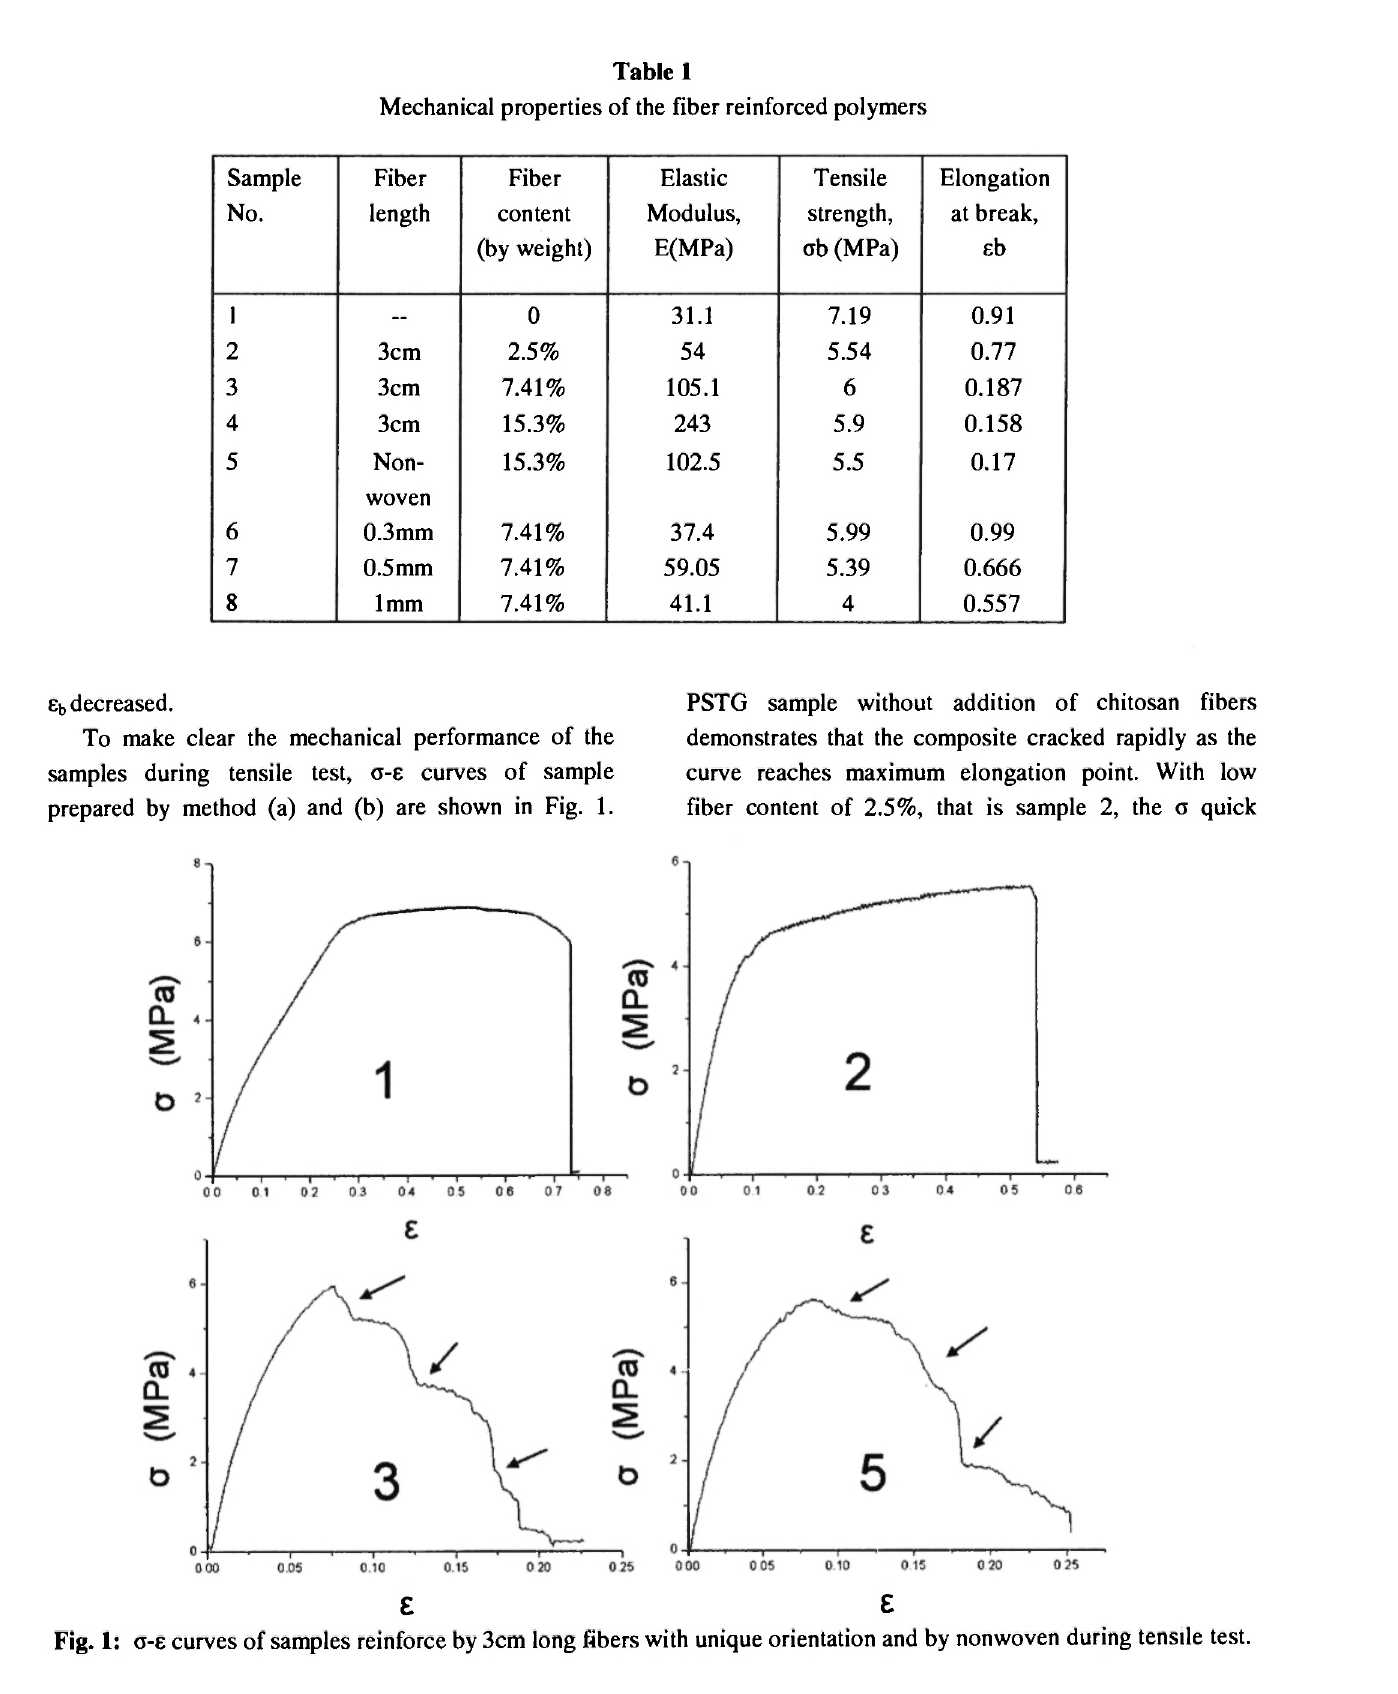
Fig. 1: σ-ε curves of samples reinforce by 3cm long fibers with unique orientation and by nonwoven during tensile test.